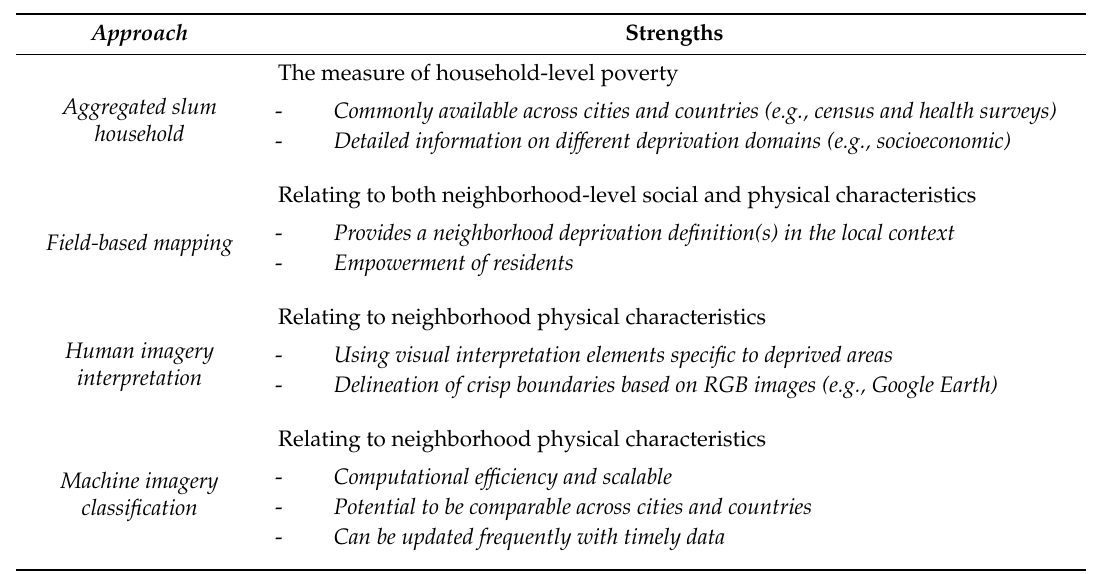
Table 2. Strengths of the existing approaches to deprived area